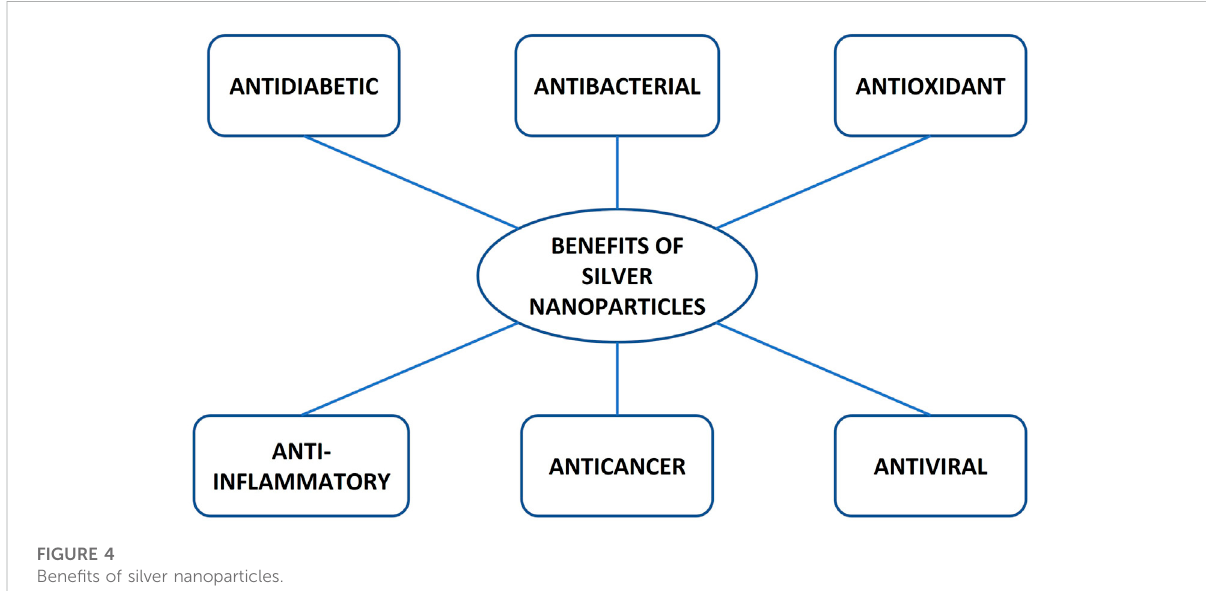
FIGURE 4 Bene fi ts of silver